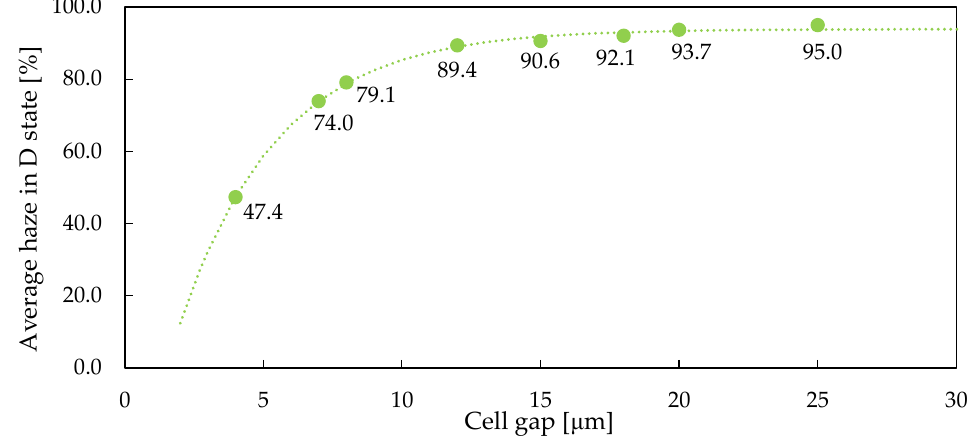
Figure 9. Diffuse (D) haze measurements for various cell gaps.